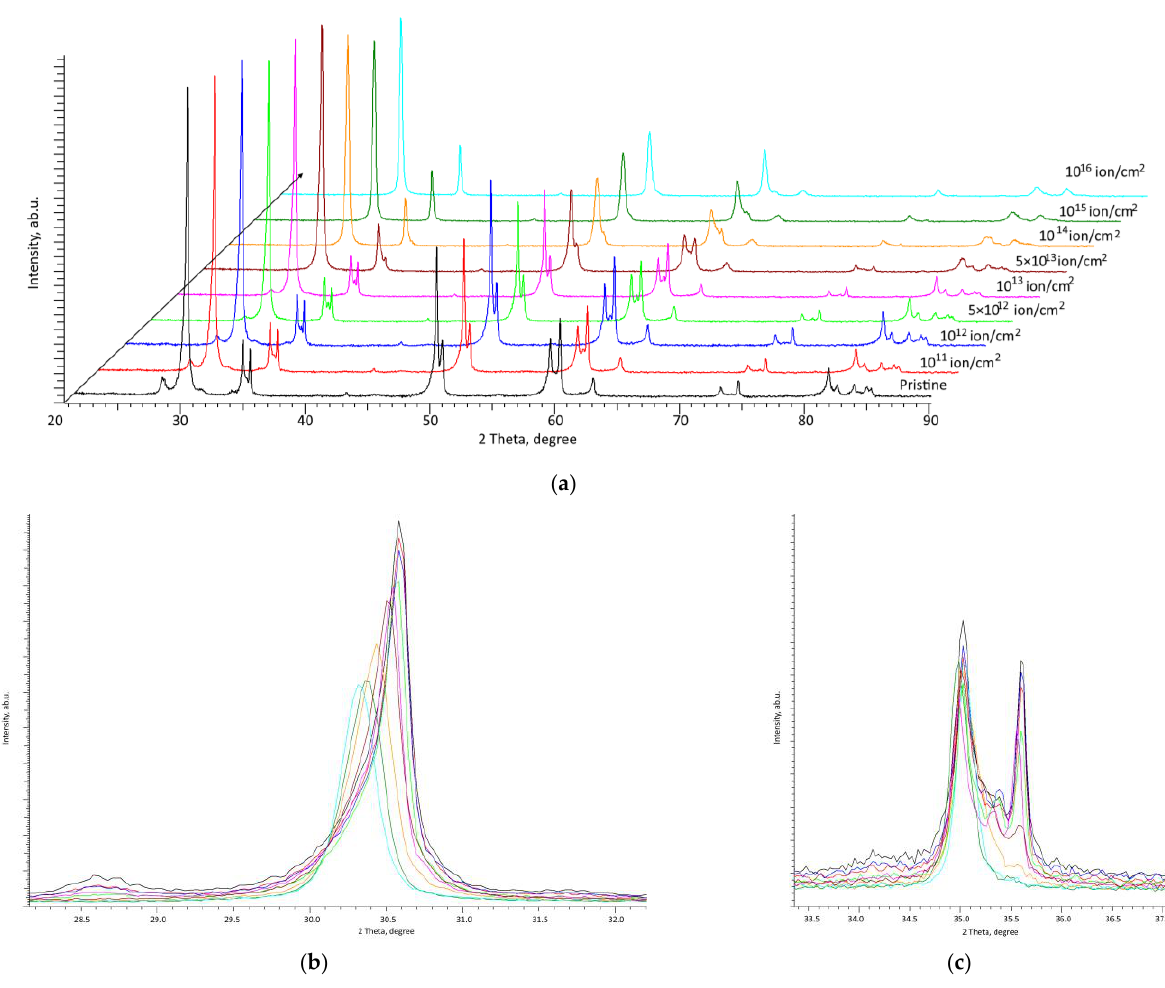
along the trajectory of ions in the material, short-lived (10 −1 3 s) regions with an increased